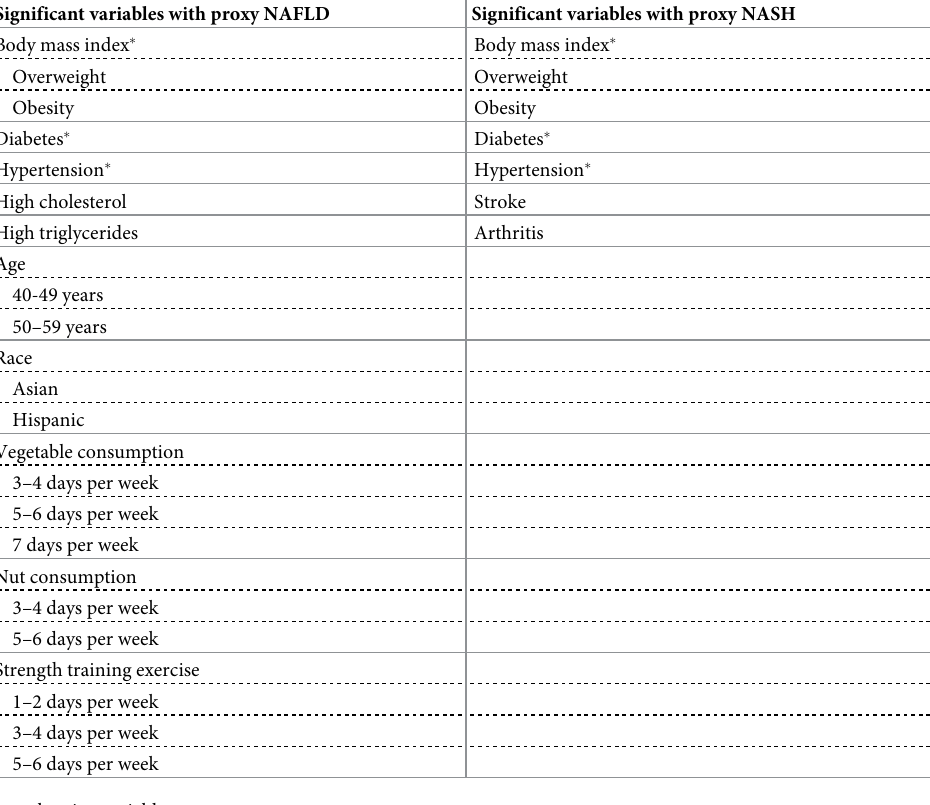
Among the population with a proxy NAFLD diagnosis in this study (n = 374), 67% were clinically obese (BMI greater than 30), 38% were diabetic, 34% had hypertension, 33% had high cholesterol, and 16% had high triglyceride levels. Among the population with a proxy NASH diagnosis in this study (n = 49), 90% were clinically obese, 45% were diabetic, 45% had hypertension, 6% had a history of stroke, and 35% had a history of arthritis. Table 6. Variables with statistically significant relationships to proxy NAFLD and NASH